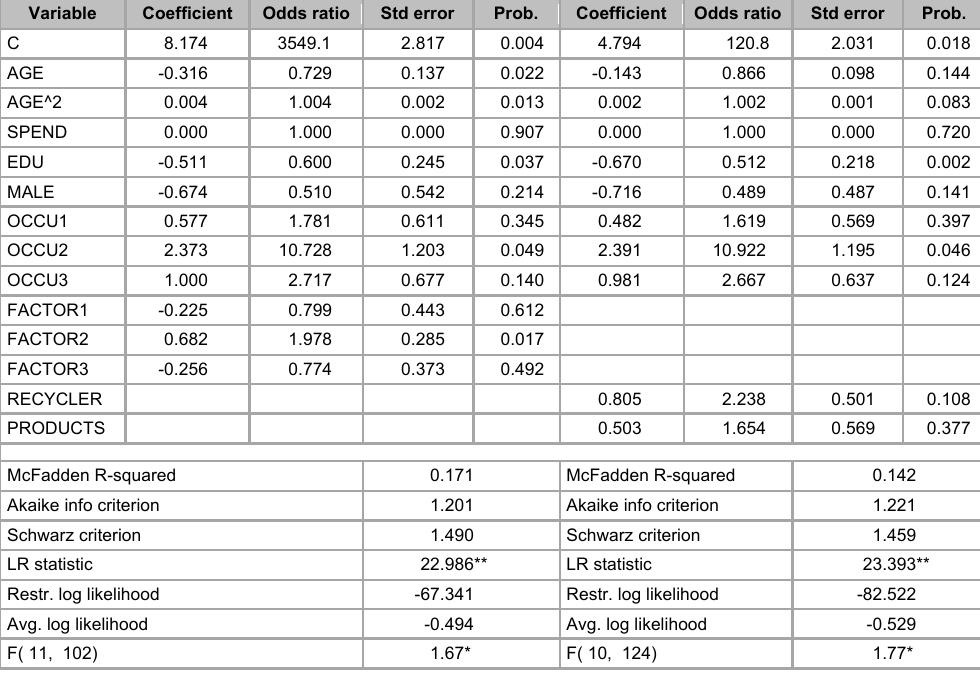
Results of the logistic regression analysis (1st